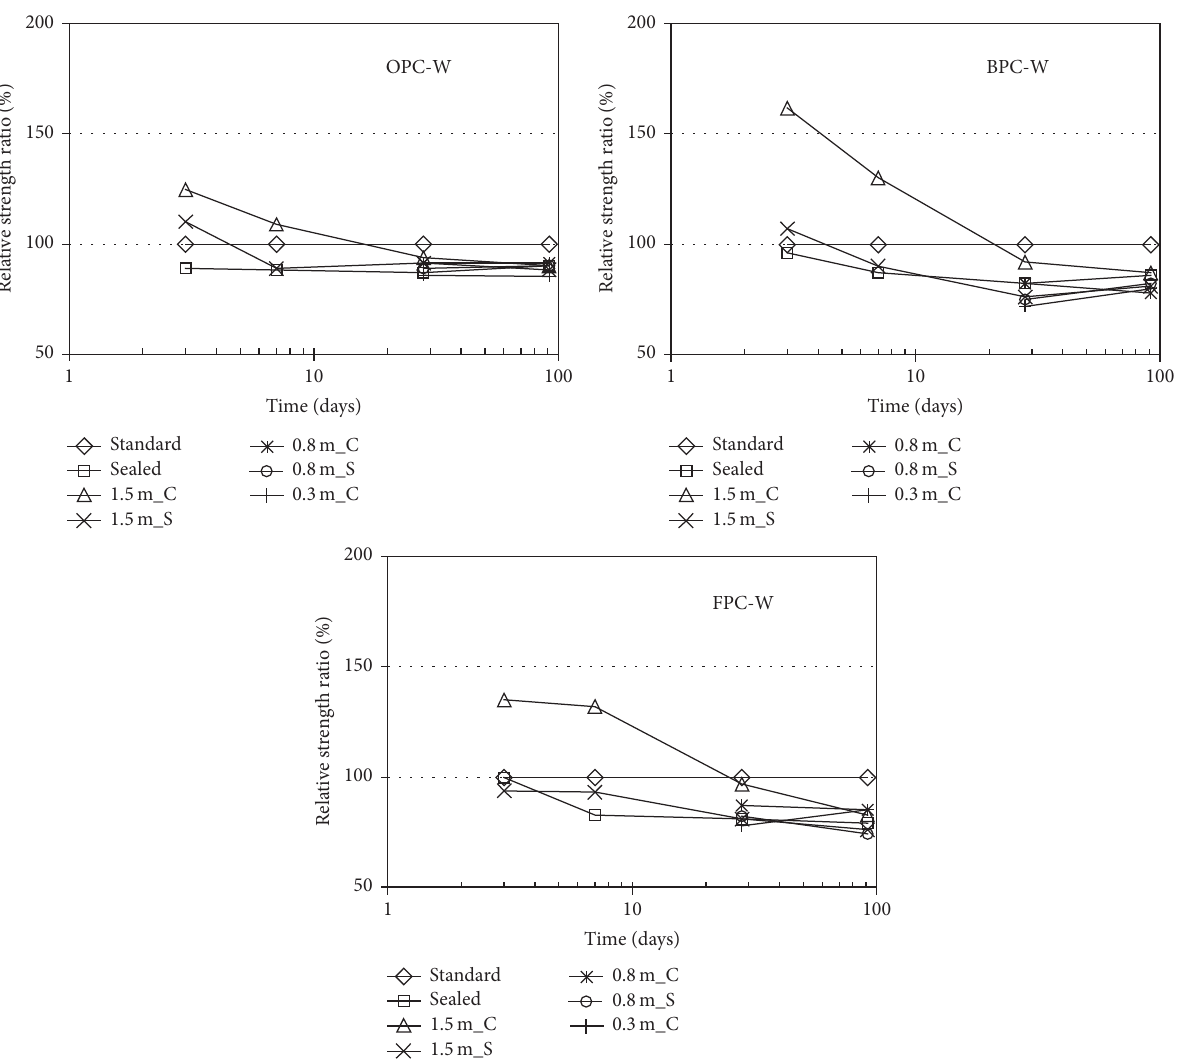
Figure 4: Effect of temperature on strength development of concrete at